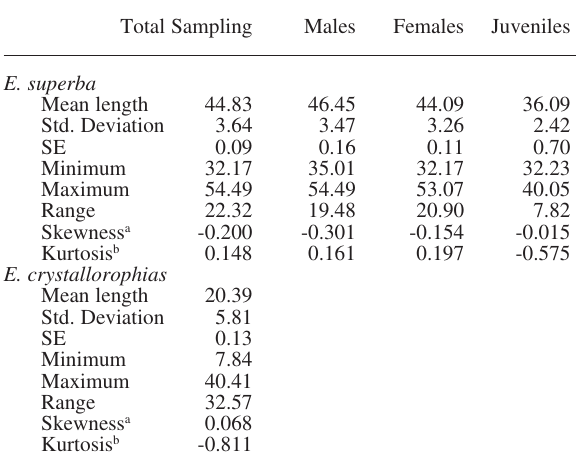
T ABLE 5. – Descriptive statistics for all the krill sampled. Statistics for males, females and juveniles of Antarctic krill are included separately.